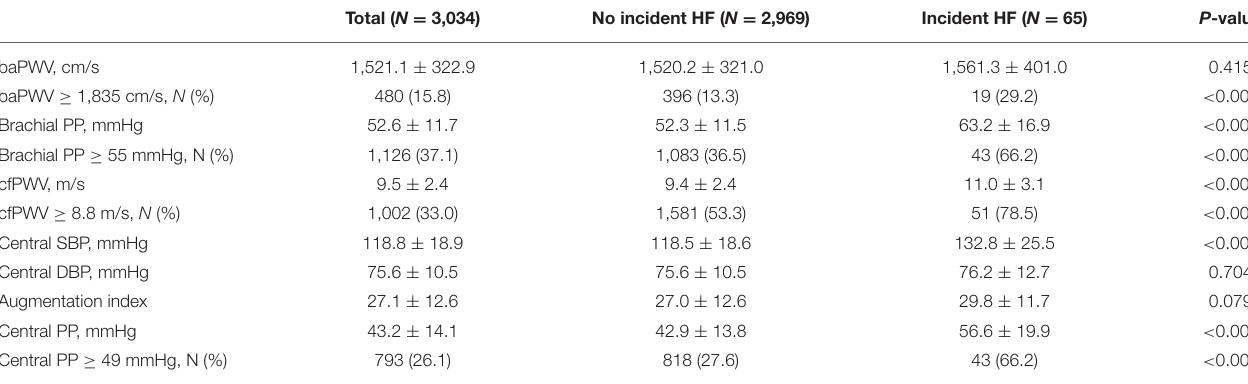
TABLE 2 | The arterial stiffness measures and central hemodynamic parameters according to incident heart failure. Total ( N = 3,034) No incident HF ( N = 2,969) Incident HF ( N = 65) P -value baPWV, cm/s 1,521.1 ±